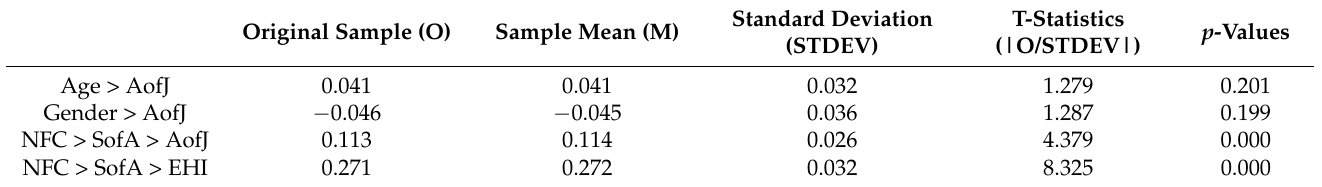
Table 3. Path coefficients and specific indirect